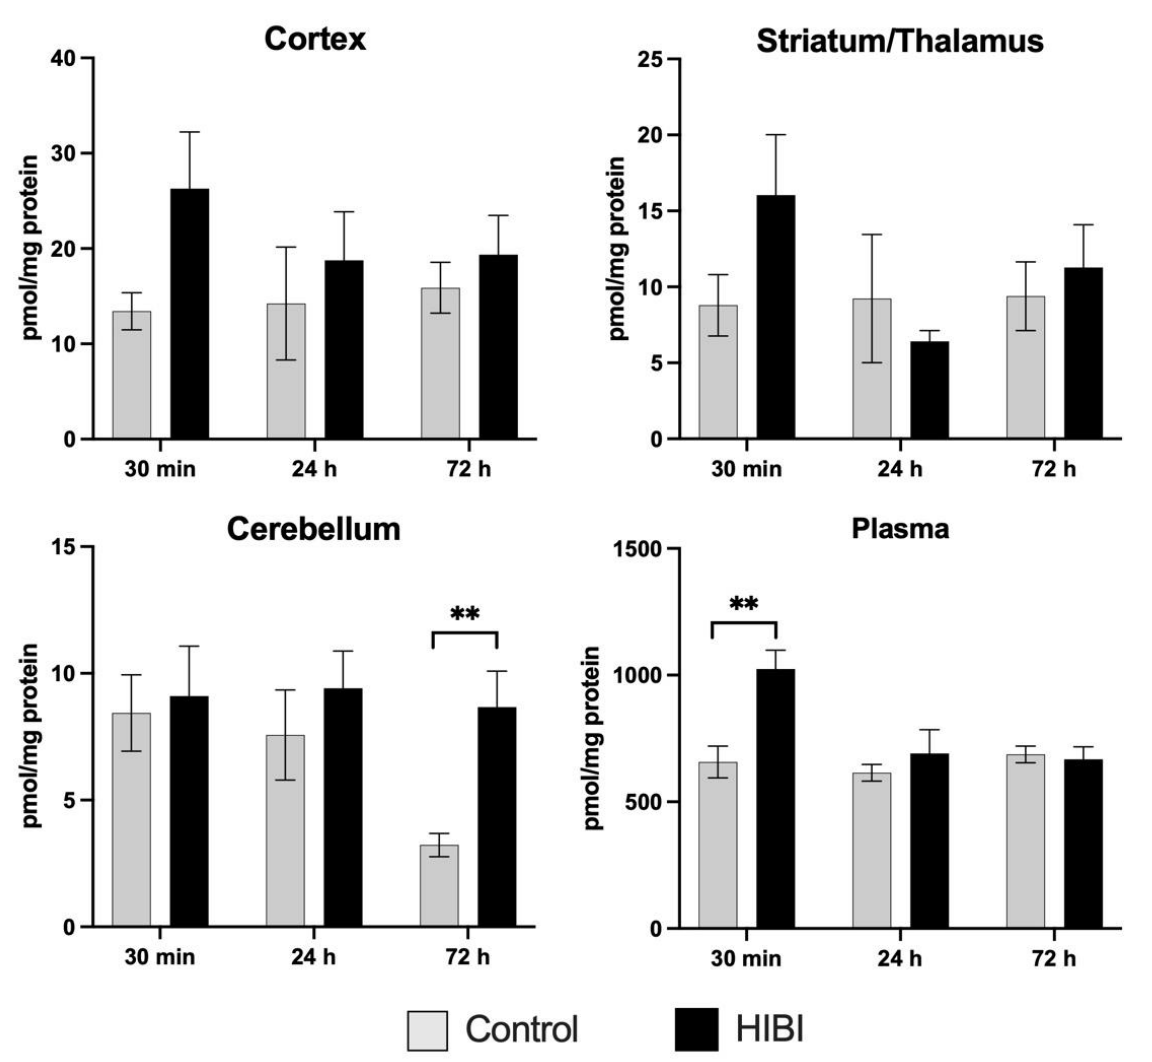
Figure 2. Total acylcarnitine levels for brain regions and plasma over time. ** p < 0.01.